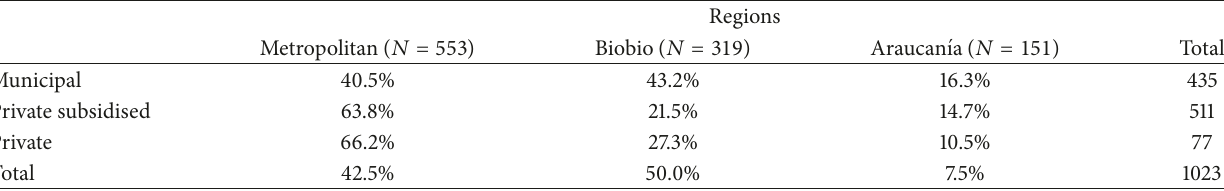
Table 1: Distribution of teachers sampled by type of school ∗ and geographical region ( 𝑁 = 1023